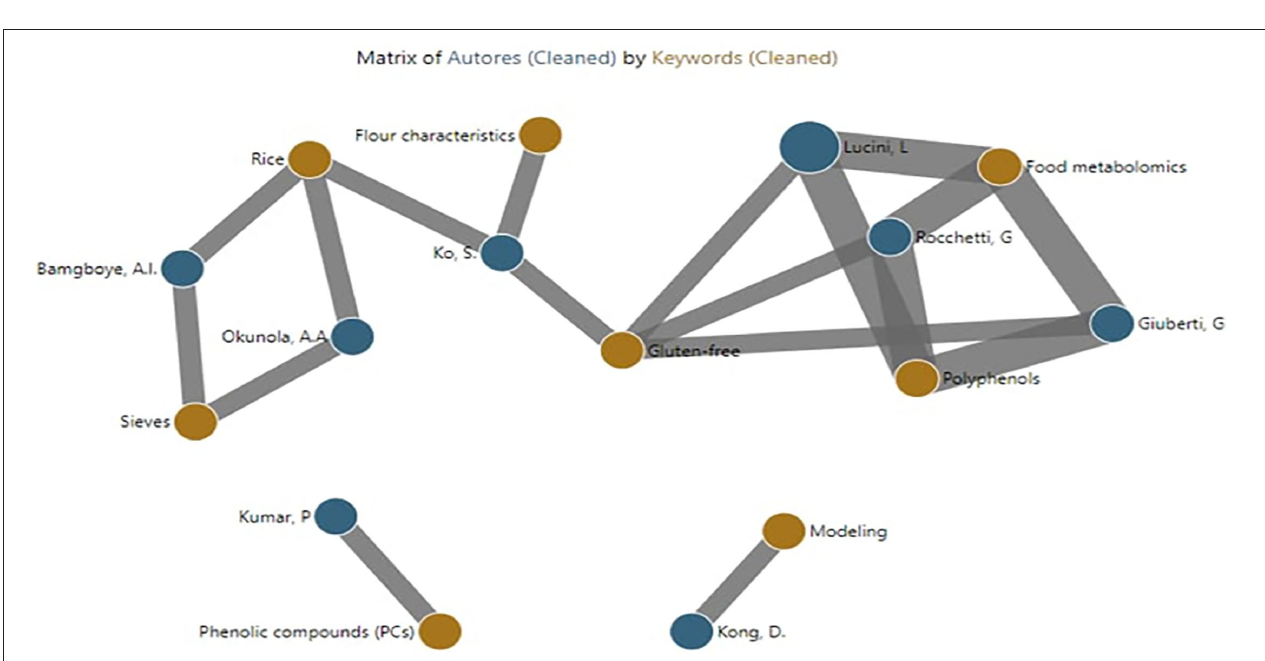
FIGURE 3 | Matrix of authors by keywords. Source: Vantage point software (through information provided by the authors).